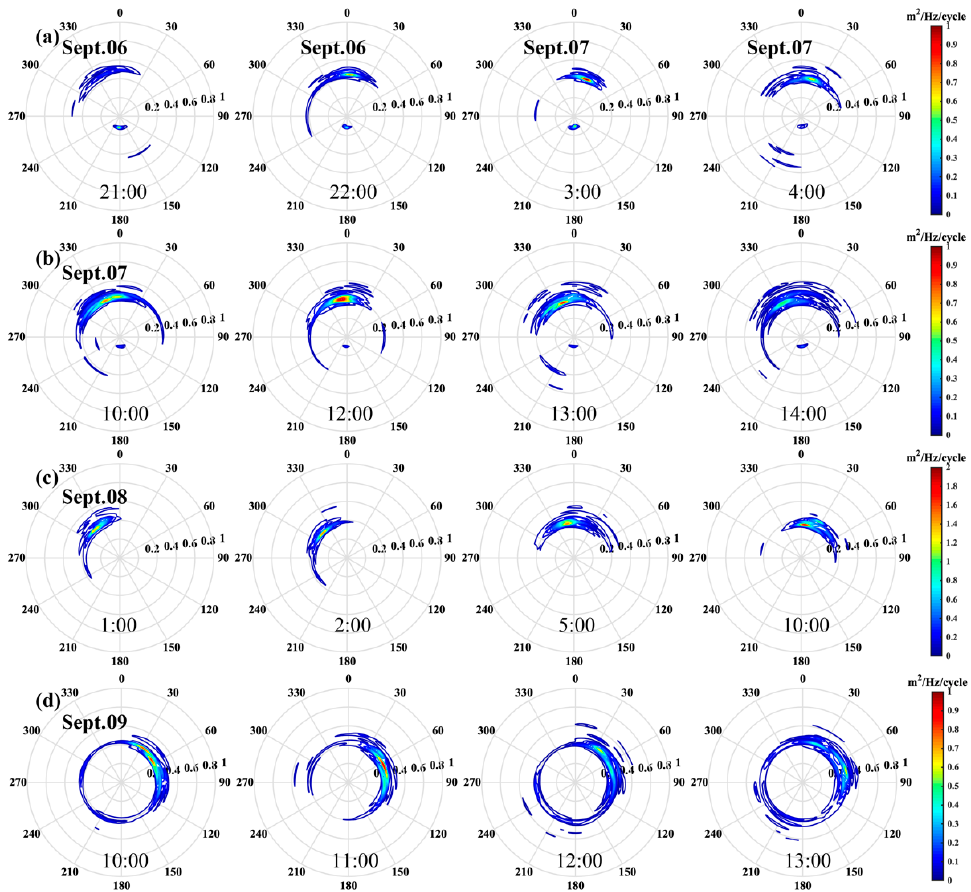
Figure 13. Hourly directional wave spectrum as observed by CSI 3 in the Case IV. The 2-D directional spectra are shown in polar contours. ( a ) Prefrontal phase, ( b ) frontal passage phase ( c , d ) postfrontal phase from September 6 to 9.